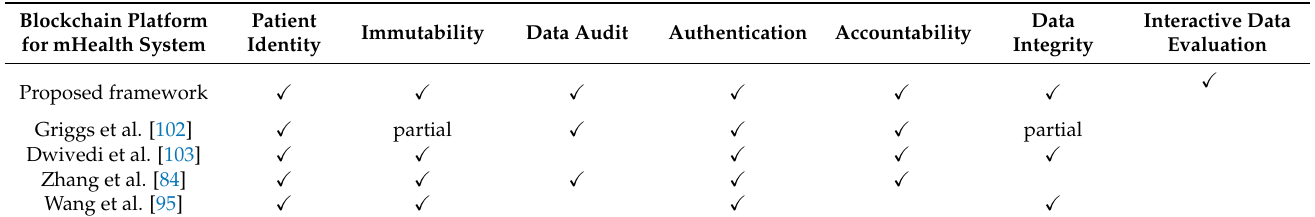
Table 4. A comparative analysis of the proposed framework vs the state-of-the-art systems Blockchain Platform for mHealth